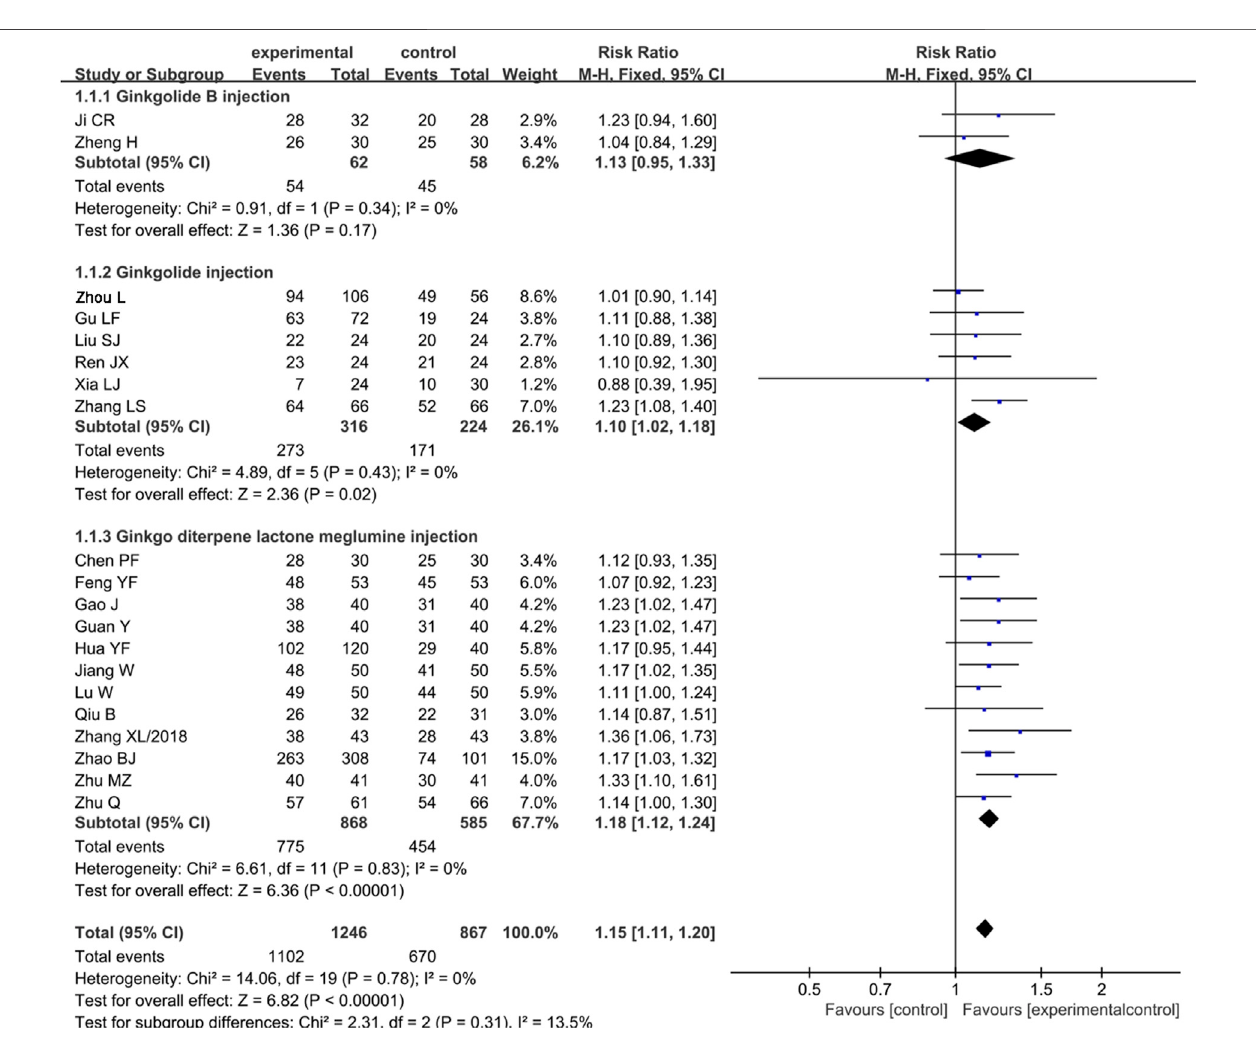
FIGURE 3 | Forest plot of ginkgo terpene lactone preparations on clinical ef fi cacy.